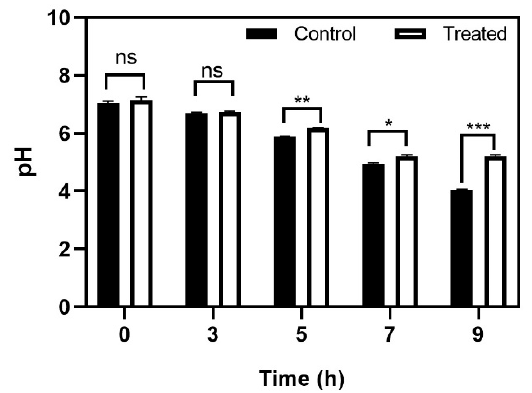
Figure 7. Effect of baicalein on S. mutans acid production. The time dependent effect on glycolytic pH drop. Student t -test was used for analysing significance and p < 0.05 was considered significant. * denotes p ≤ 0.05, ** denotes p ≤ 0.01 and *** denotes p ≤ 0.001.